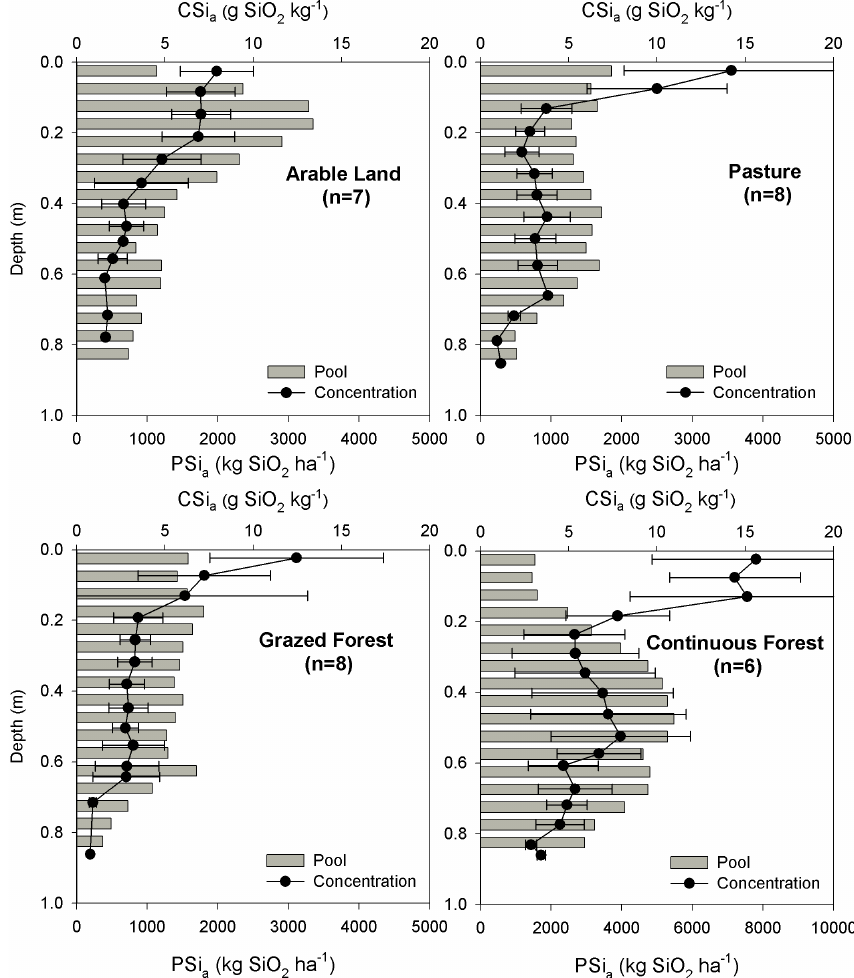
Fig. 2. Average distribution of alkaline (Na 2 CO 3 ) extracted silica (CSi a , gSiO 2 kg − 1 dry soil) and total CSi a -pools (PSi a , kgSiO 2 ha − 1 ) by depth under various land uses in southern Sweden soils. N =number of profiles analysed under specific land use. Scale x-axis not